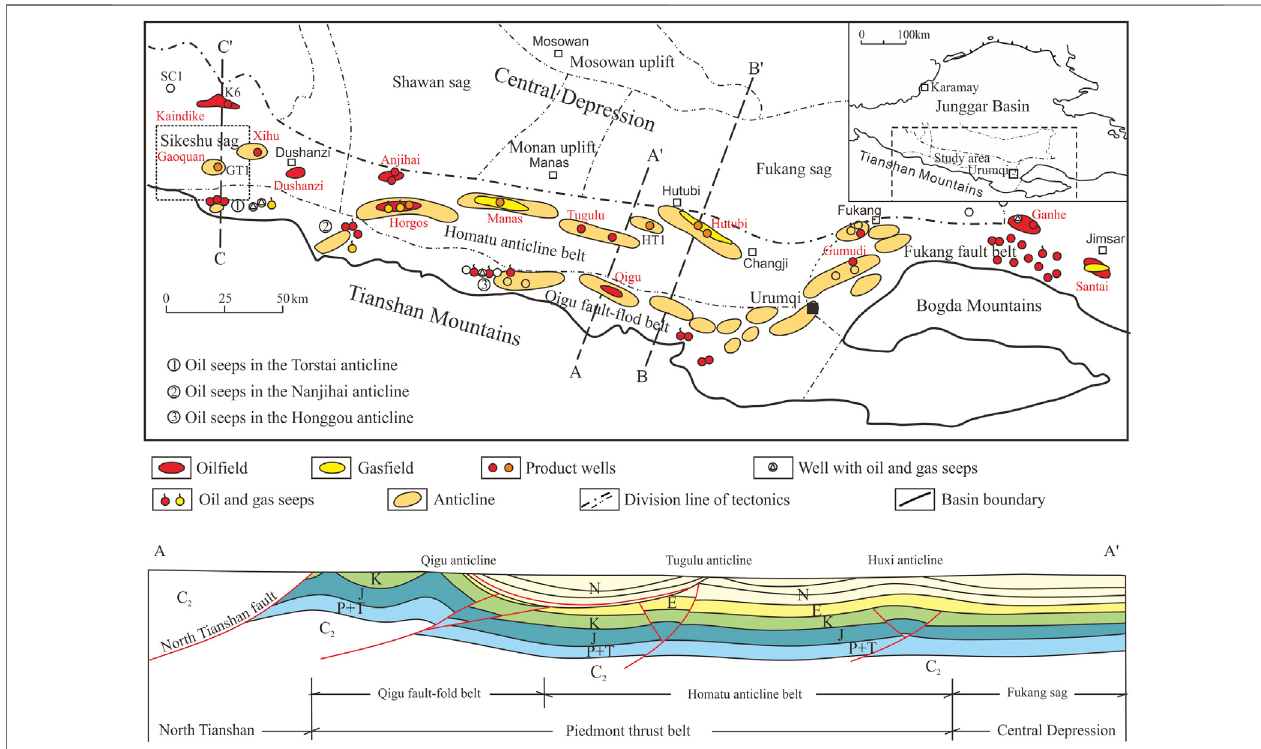
FIGURE 1 | Distribution of structural traps and of oil and gas fi elds in the southern margin of Junggar Basin.